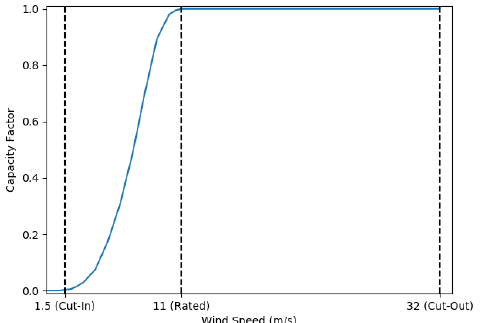
Figure 2. Wind turbine power curve used, with bounding curve calculated from all available turbine data provided by the Open Energy Platform